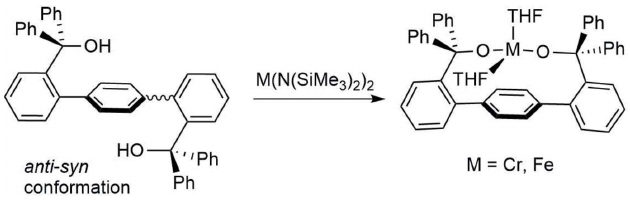
Figure 1 Schematic representation of the ‘ anti – syn’ structure of the previously synthesized H 2 [OO] Ph ligand and its reactivity with transition-metal